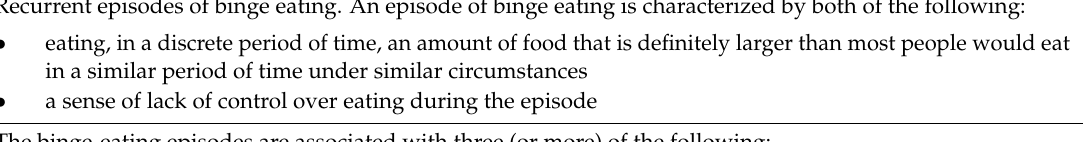
Table 1. DSM-V diagnostic criteria for binge eating disorder